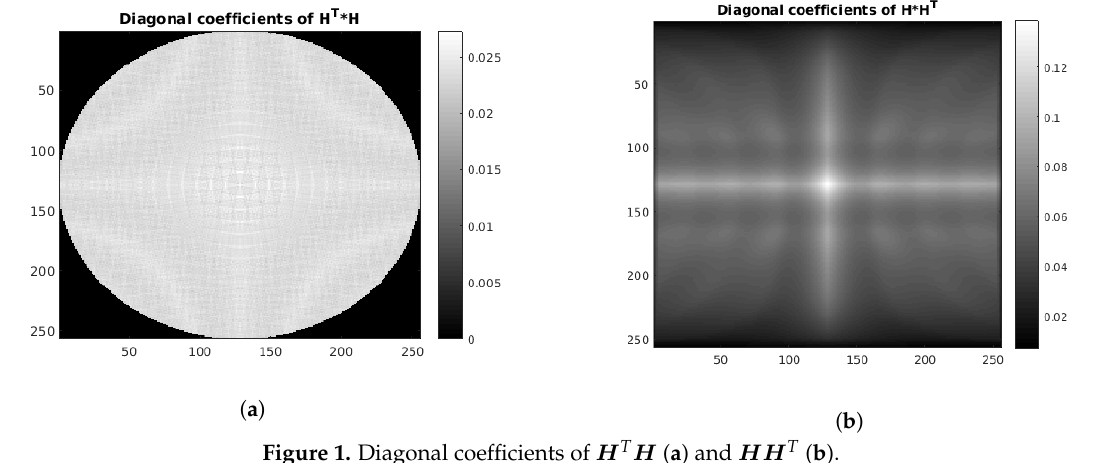
Figure 1. Diagonal coefficients of H T H ( a ) and HH T ( b ).